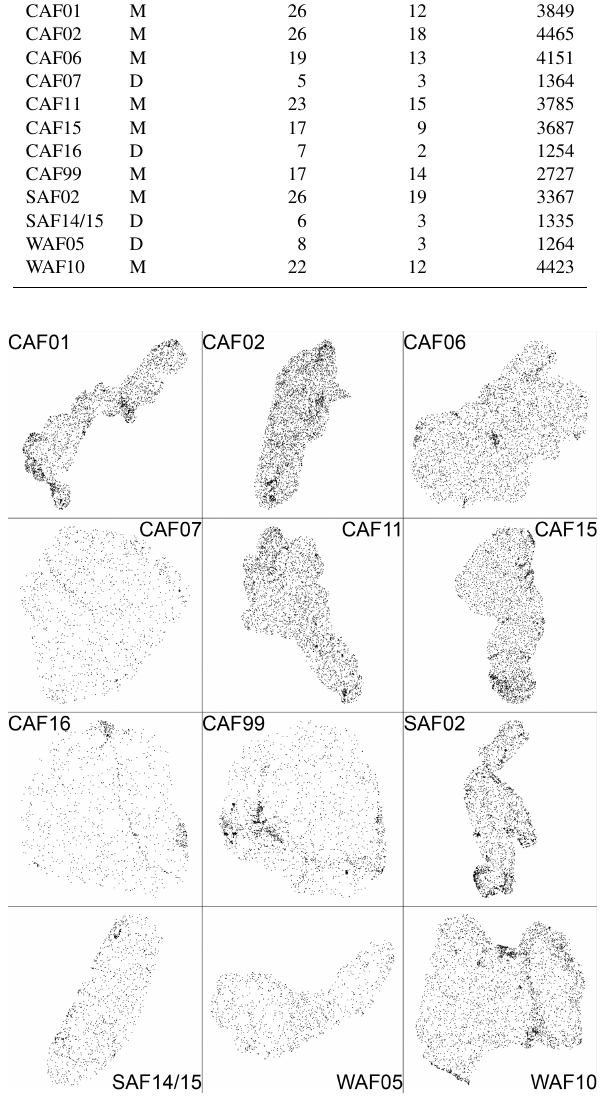
Figure 3. Spatial distribution of the validation datasets within each key landscape for conservation